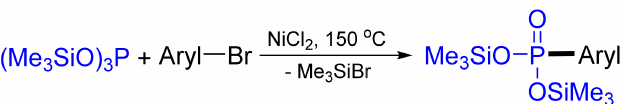
Figure 28. The catalytic arylation of tris(trimethylsilyl)phosphite.